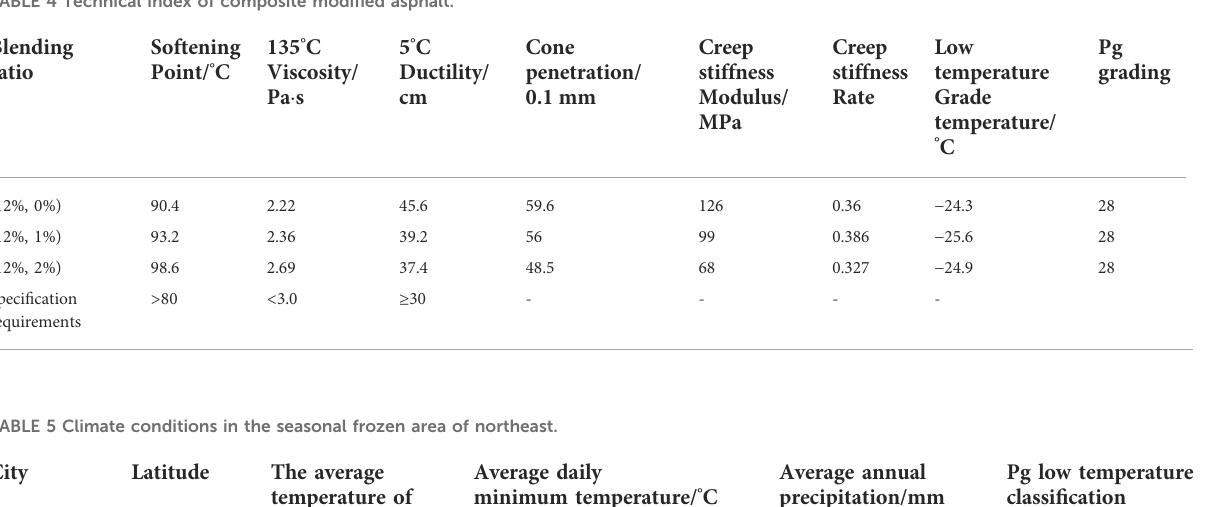
TABLE 4 Technical index of composite modi fi ed asphalt.